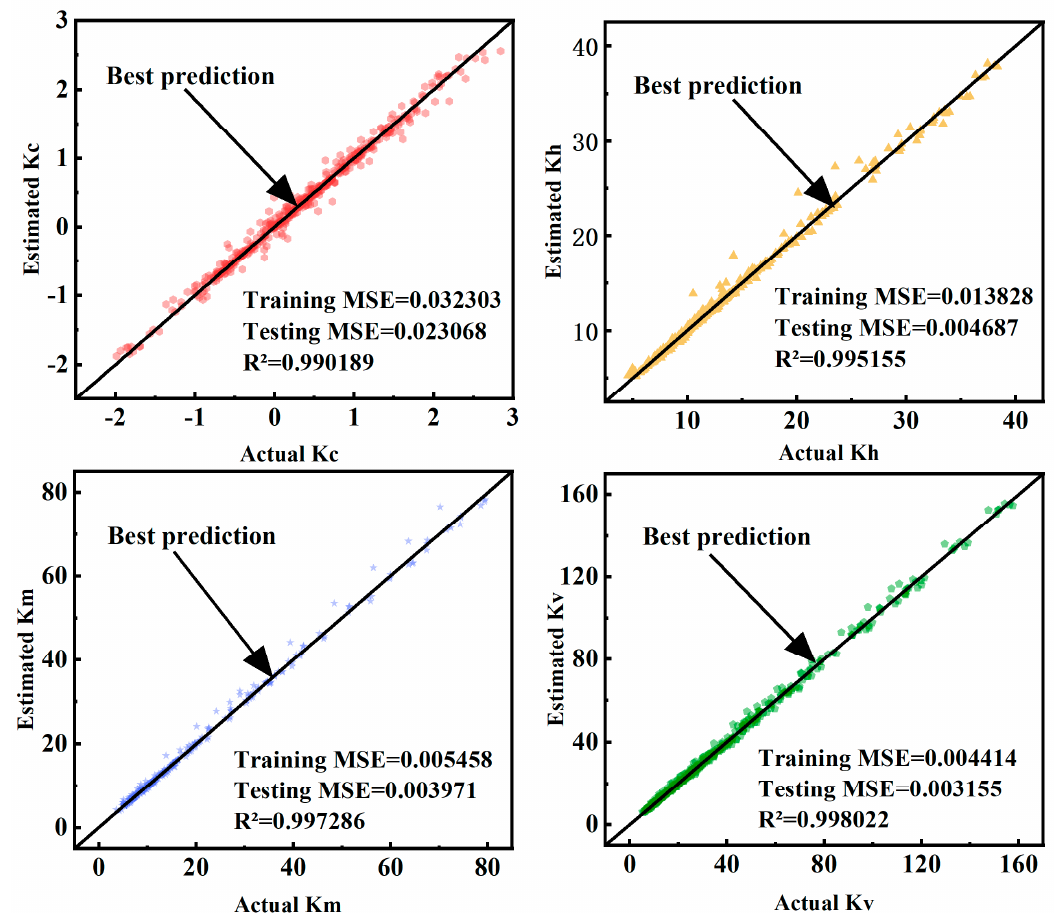
Figure 9. Scatter plot of the actual and predicted dimensionless elastic stiffness coefficients.